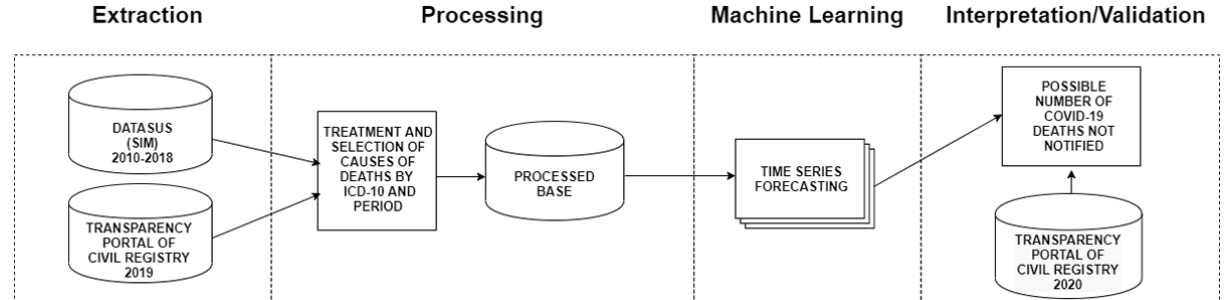
Figure 1. Methodology diagram adapted from Fayyad et al [21]. DATASUS: Department of Informatics of the Unified Healthcare System; SIM: Mortality Information System; ICD-10:International Statistical Classification of Diseases and Related Health Problems–10th Revision; COVID-19: coronavirus